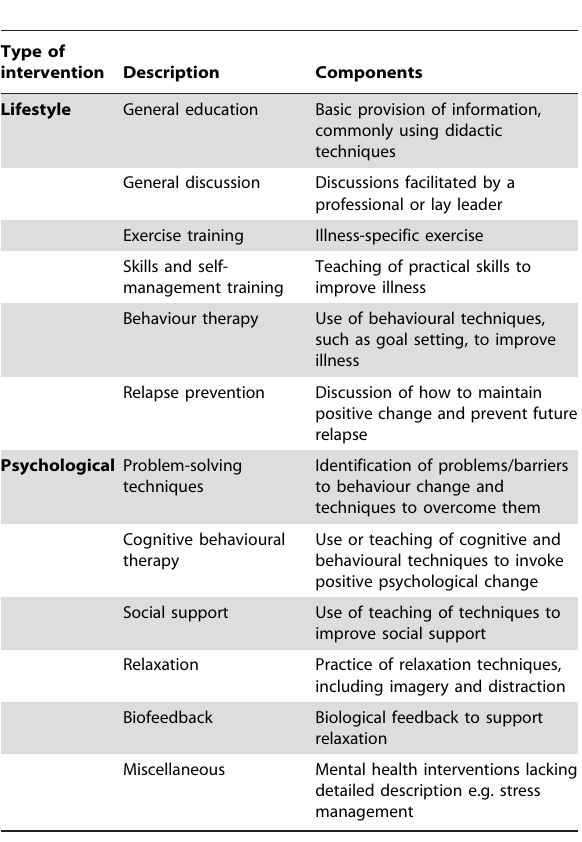
Table 1. Classification of intervention